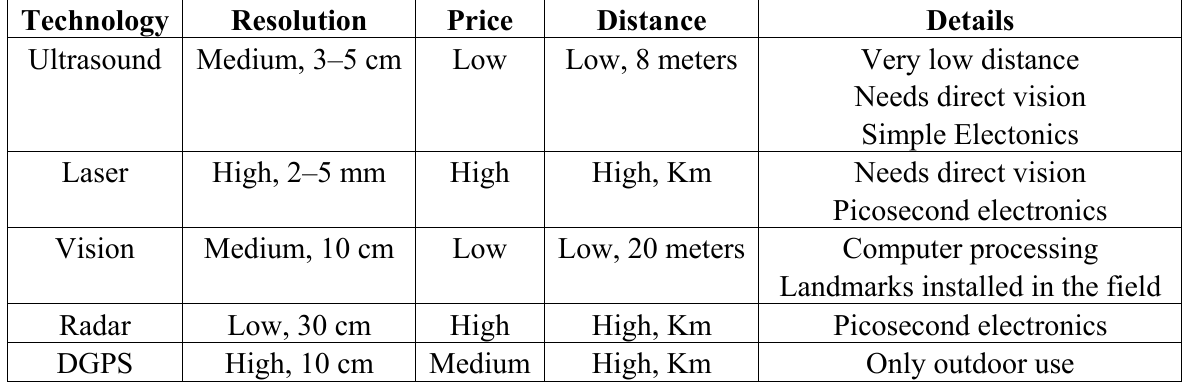
Table 1. Comparison with other distance measurement